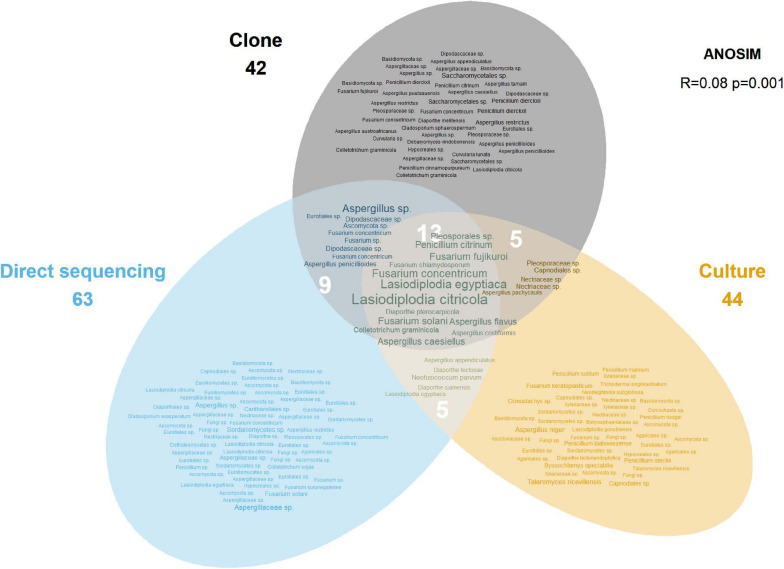
Euler diagram showing the OTUs recovered by each sampling approach. The size of labels is proportional to the number of occurrences for that OTU. Numbers under method labels and in intersections indicate the total number of OTUs for the corresponding approach(es). The ANOSIM result in the top right indicates the statistical significance of the different approaches.